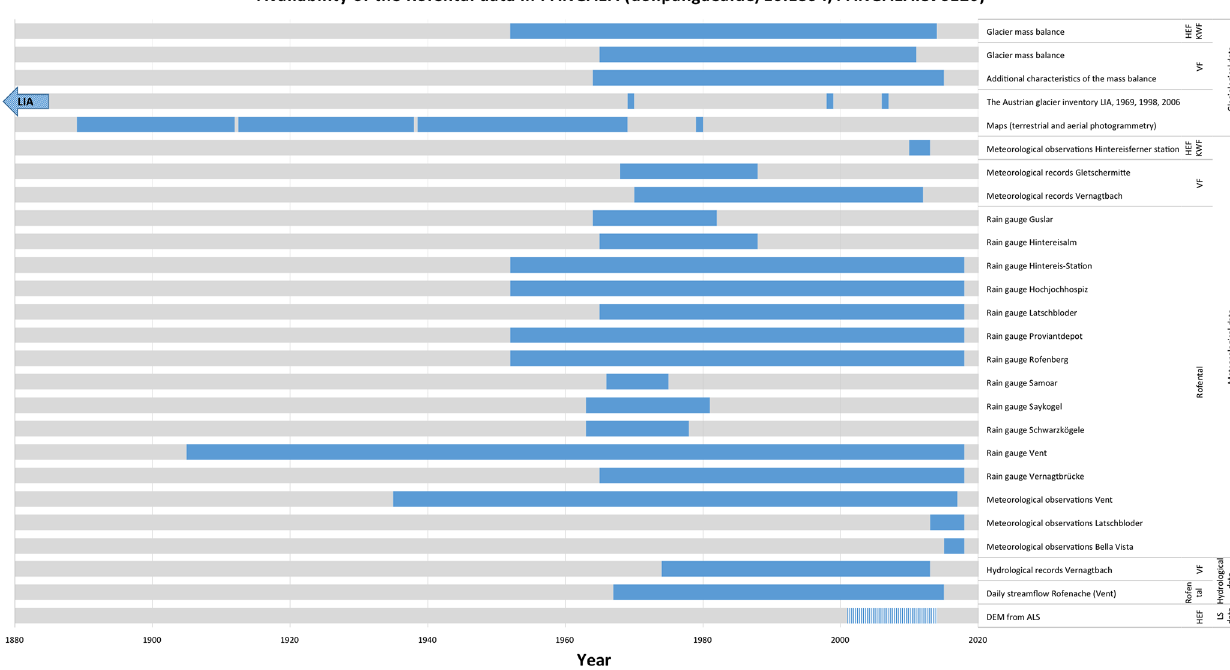
Figure 6. Available data time series for the Rofental in PANGAEA, structured in glaciological data, meteorological data, hydrological data and laser scanning data. LIA = little ice